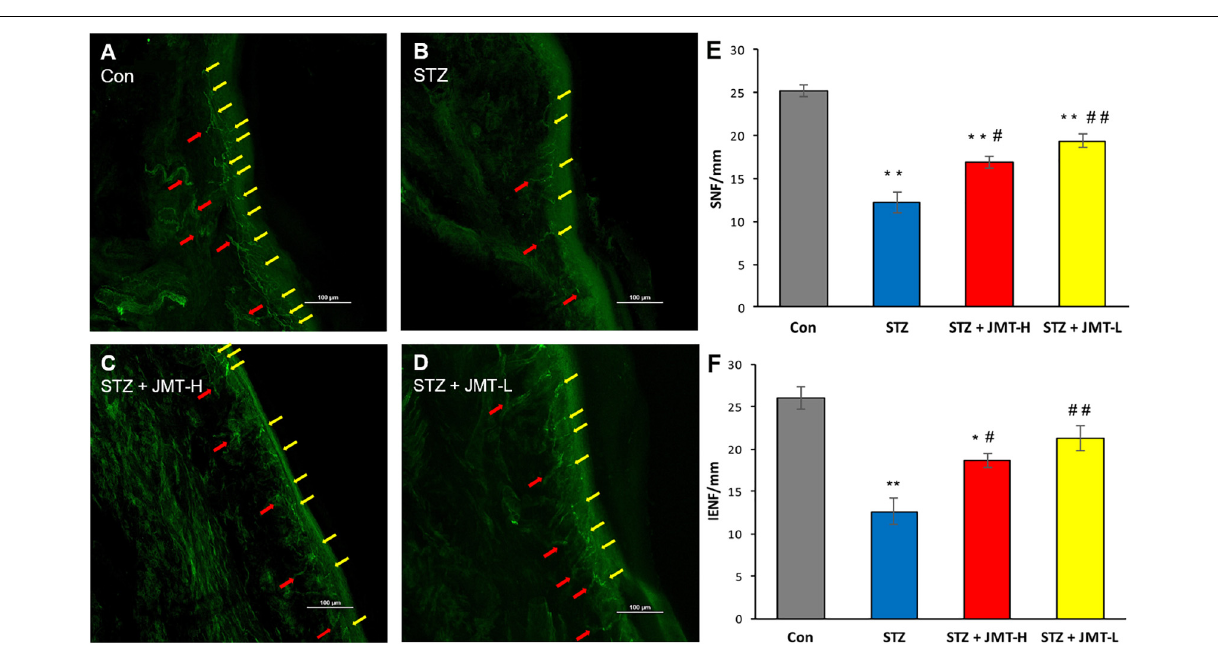
FIGURE 3 | Foot skin nerve profiles detected by immunofluorescence assay. (A–D) Representative images of immunofluorescence staining of hind paw plantar skin nerves. The yellow arrows point PGP 9.5 immuno-reactive intraepidermal nerve fiber (IENF) and the red arrows point subepidermal nerve fiber (SNF). Magnification: 20 × , scale bars: 100 µ m; (E) SNFD (fibers/mm); (F) IENFD (fibers/mm). Data are group mean ± SEM ( n = 3 per group). * P < 0.05 and ** P < 0.01 vs. control group; # P < 0.05 and ## P < 0.01 vs. untreated STZ group by ANOVA with Dunnett’s post-hoc